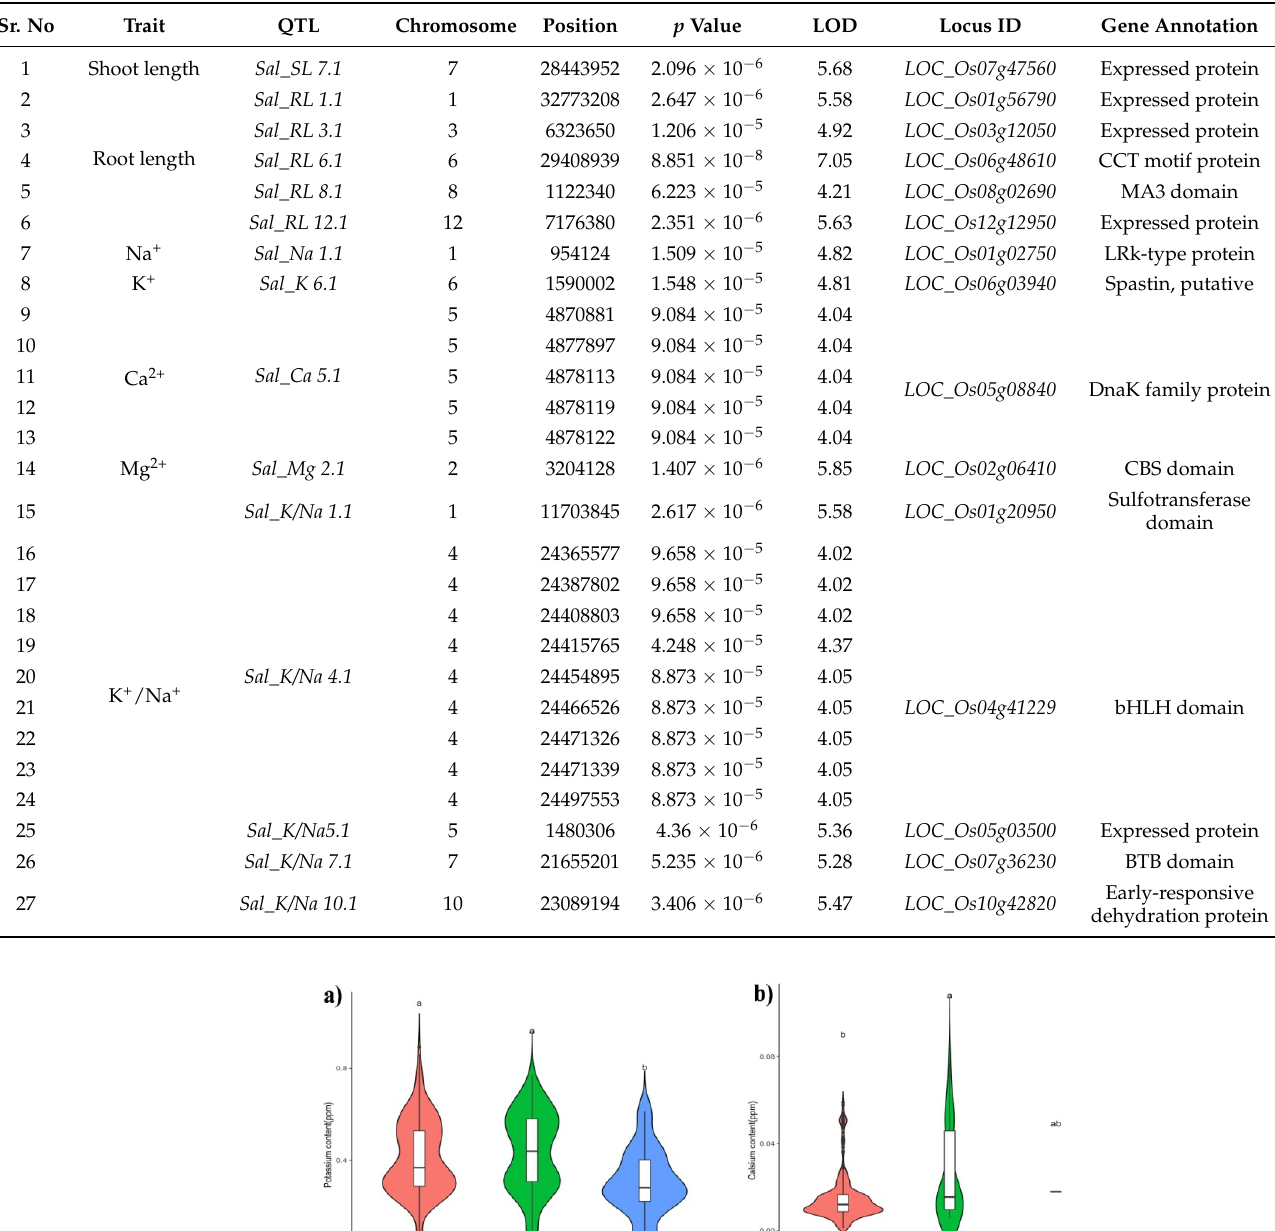
Table 1. Associated QTLs with SNP position and probable candidate genes for salinity tolerance in MAGIC population.